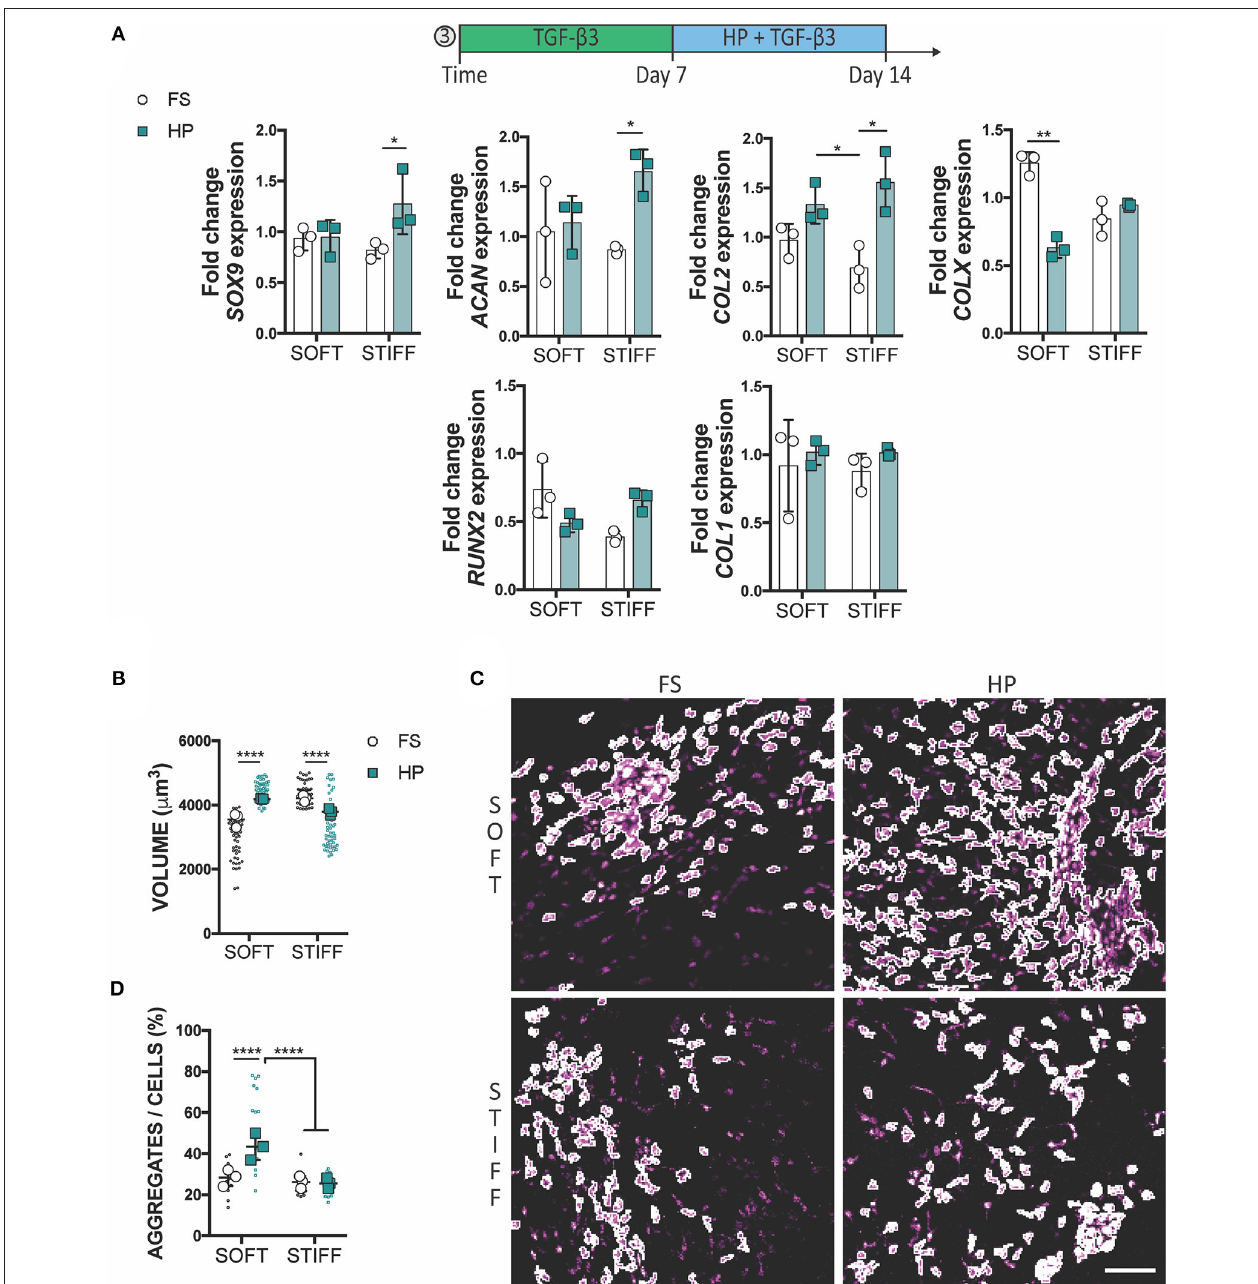
FIGURE 5 | Delayed exposure to HP enhances chondrogenesis. (A) Gene expression analysis of MSCs cultured for 1 week in presence of TGF- β 3 followed by 1 week of HP and TGF- β 3. (B) Graphs reporting single cell volume after 14 days of culture. (C) Representative images of cell aggregates and (D) their quantification. Cells stained for actin (magenta). Scale bar 100 µ m, * p < 0.05, ** p < 0.01, **** p < 0.0001.